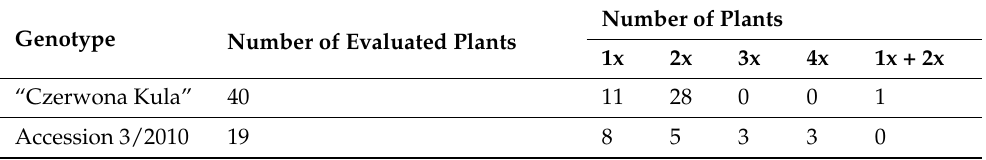
Table 9. Ploidy of red beet gynogenetic plants in red beet “Czerwona Kula” and 3/2010 breeding accession.